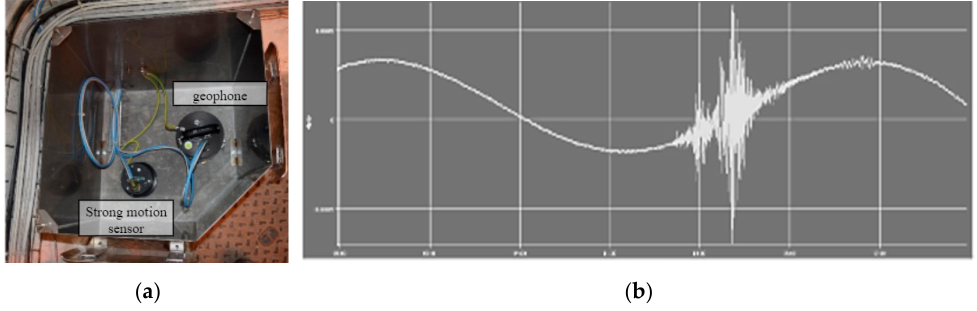
Figure 1. ( a ) Seismic station sensor chamber overview [15]; ( b ) LHC beam orbit oscillation on 13 November 2016 between 5:00 a.m. and 7:00 p.m. GMT (UTC + 1) with a peak magnitude of Mw 7.9